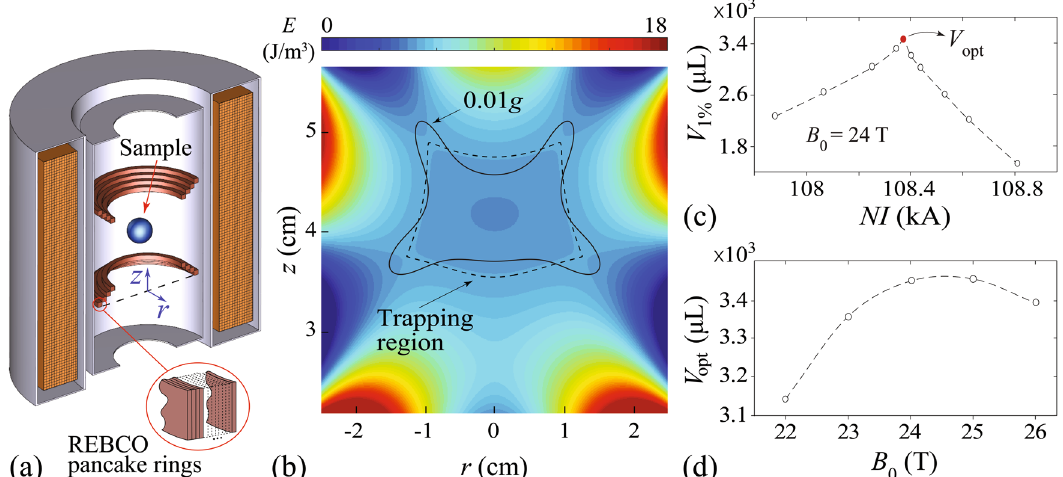
Fig. 5 Functional volume analysis for a practical MLS setup. a Schematic of a practical MLS setup that consists of a 24-T superconducting magnet with four sets of gradient- fi eld Maxwell coils made of REBCO pancake rings. The averaged diameter of the pancake rings is ~8 cm. b Calculated speci fi c potential energy E ( r ) for a small water sample placed in this MLS with a total turn-current NI = 108.37 kA. The origin of the coordinates is at the center of the lowest pancake ring. The dashed contour denotes the boundary of the trapping region and the solid contour shows the 0.01 g low-force region. c Calculated V 1% versus the turn-current NI at B 0 = 24 T. The peak V 1% is denoted as V opt . b The obtained V opt as a function of B 0